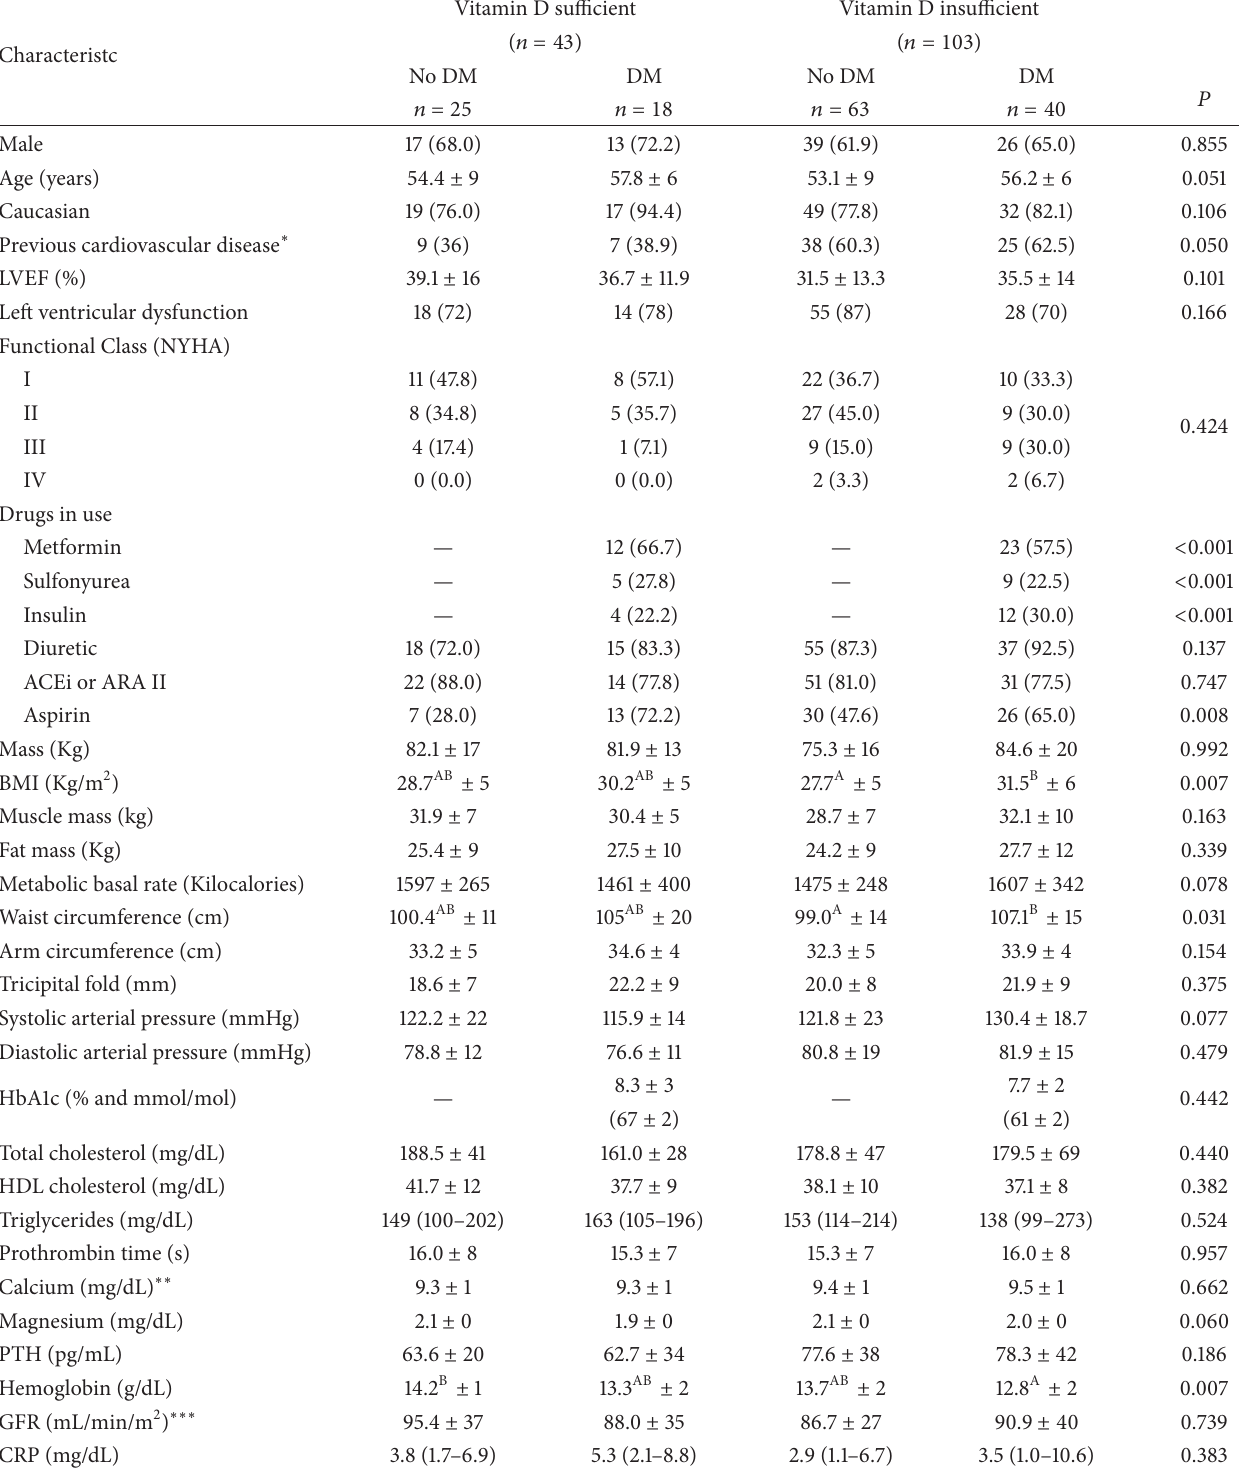
Table 1: Clinical and biochemical characteristics according to vitamin D status and diabetes